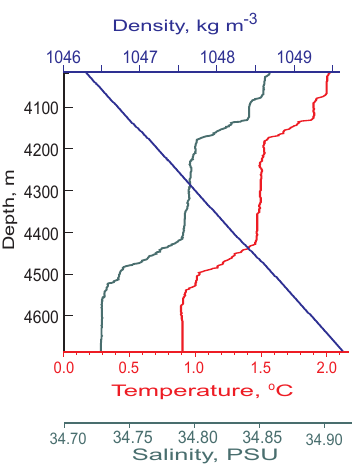
Figure 5. Profiles of the density, salinity and temperature.